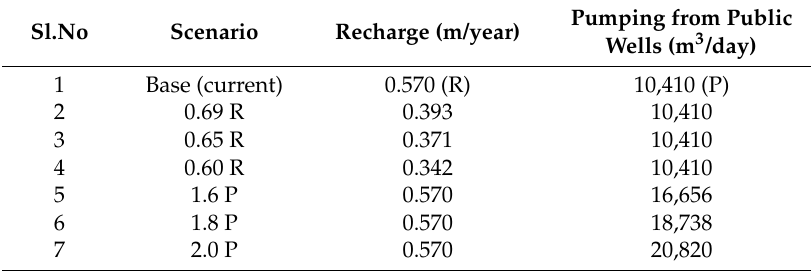
Table 1. Long-term stresses scenarios.